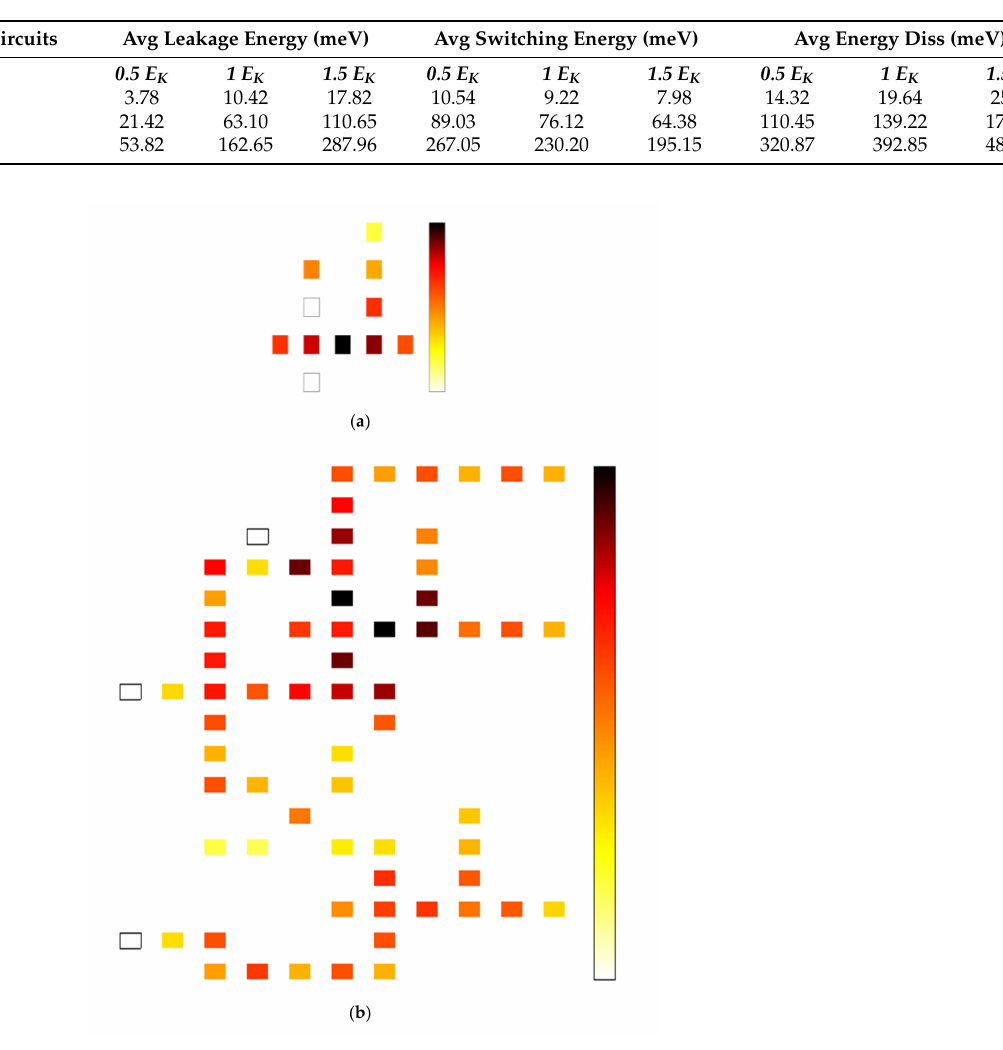
Table 8. Comparison for the proposed QCA reversible circuits by previous works.